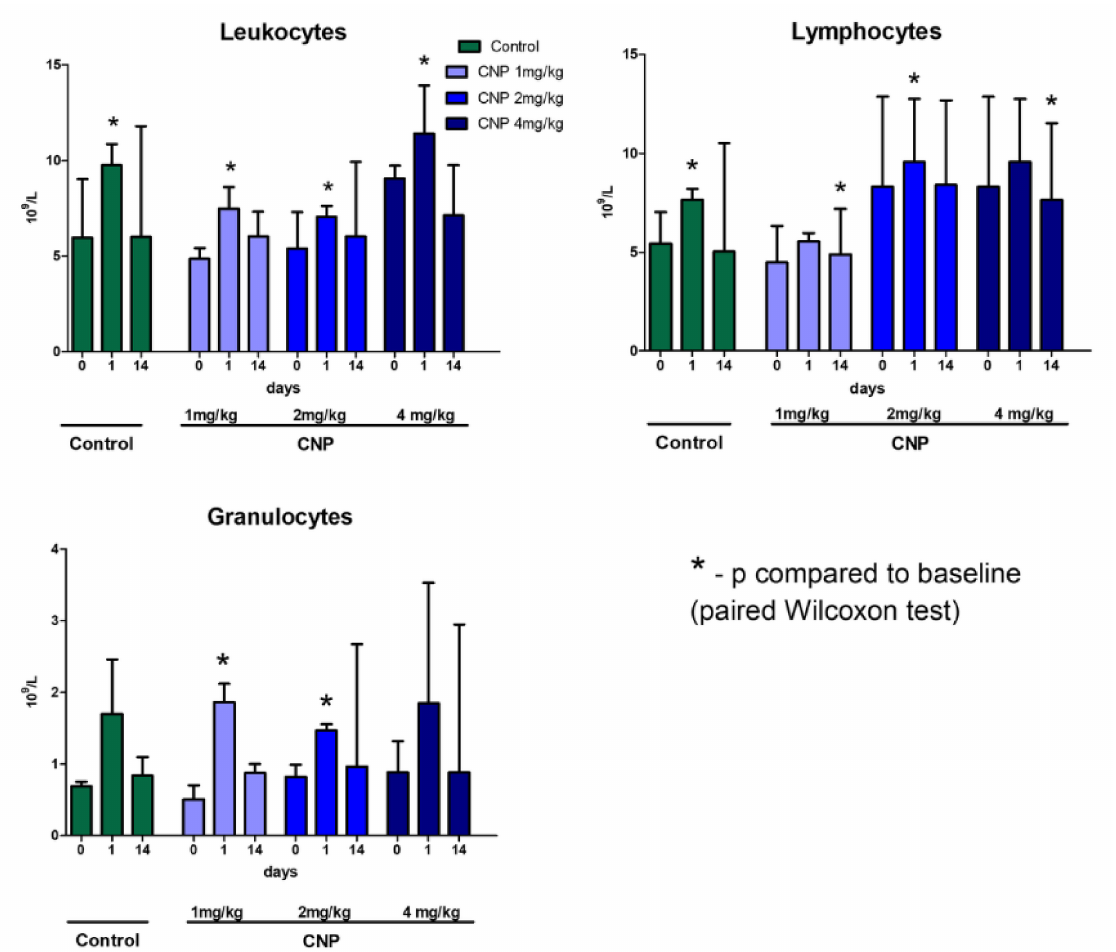
Figure 9. Dynamics of rat leukocyte parameters. Median ± range. Changes in white blood cells count were observed 1 day after injection, which were caused by minor surgical intervention